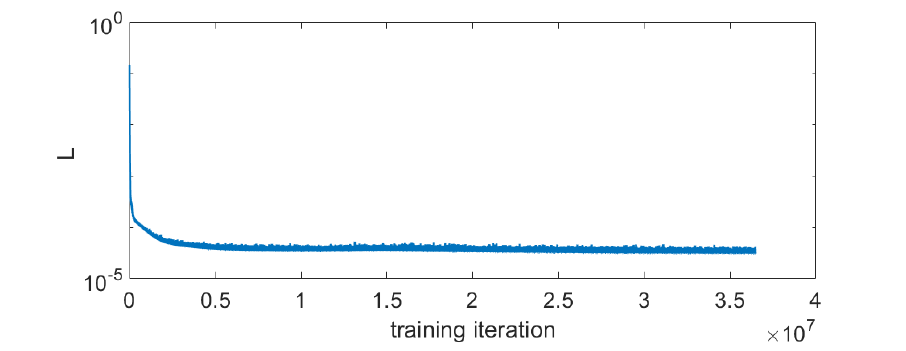
Figure 3. L as a function of training iteration for the open water neural